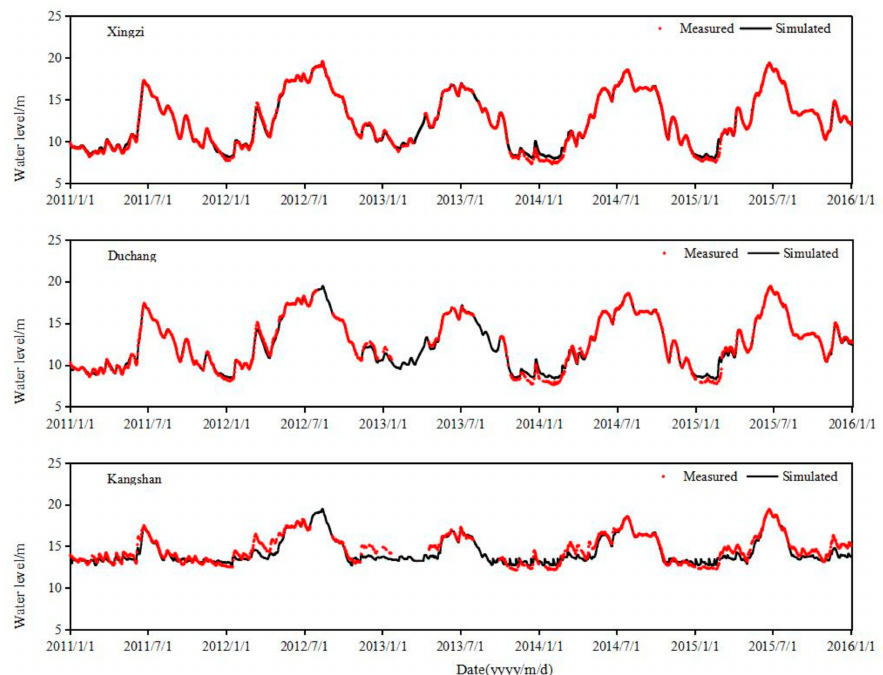
Figure 4. Comparison between model results and observations of the water level at the Xingzi, Duchang, and Kangshan gauging stations.